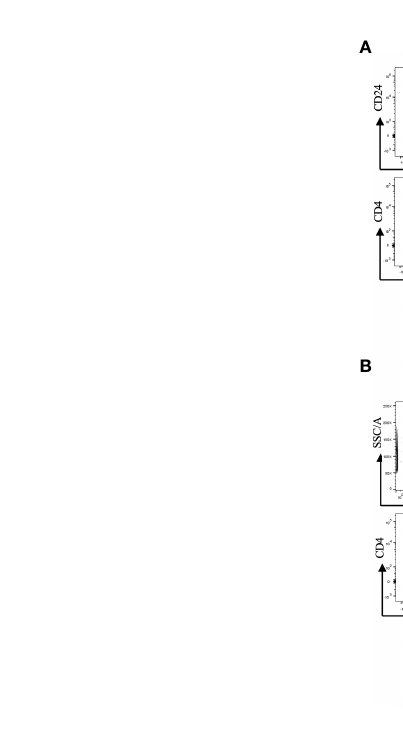
FIGURE 5 | Diminution of Zap70 expression in thymocytes and mature T cells in MHCII -/- mice expressing Lck Y505F transgene. (A) CD24/TCR and CD4/CD8 staining of, respectively, total and mature (CD24 lo TCR hi ) thymocytes is shown. Histograms show Zap70 staining and bar graph compares relative Zap70 expression in the indicated thymic subsets from MHCII -/- mice expressing or not Lck Y505F . (B) shows TCR and CD4/CD8 staining of splenic T cells, histograms for Zap70 staining and data compilation for relative Zap70 expression in CD4 and CD8 T cells from MHCII -/- mice expressing or not Lck Y505F transgene. Data are representative example of 4 or more independent experiments (n > 6 mice). *p < 0.05, **p < 0.005, ***p <